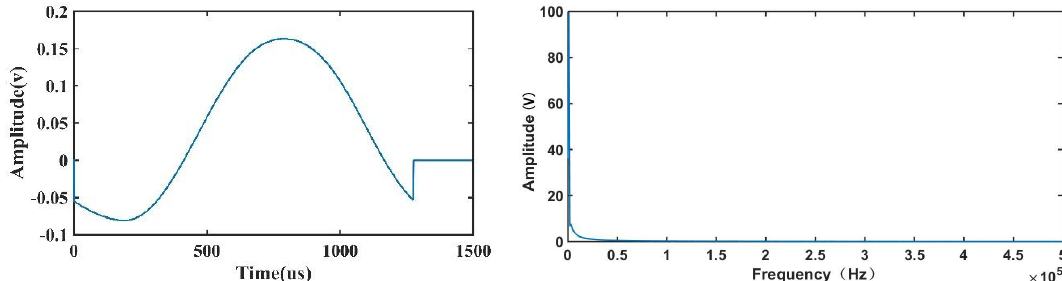
Figure 14: Typical waveform and FFT spectrogram for class2